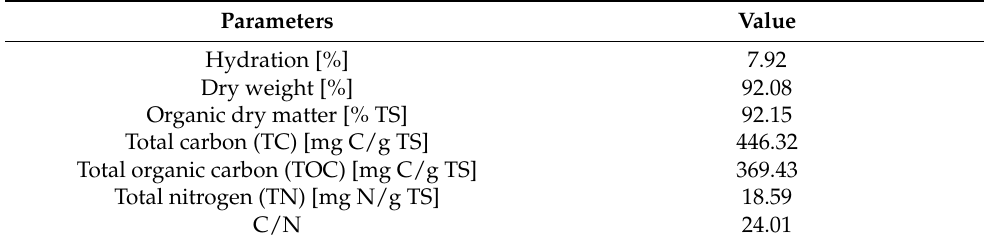
Table 1. Characteristics of the rapeseed straw.